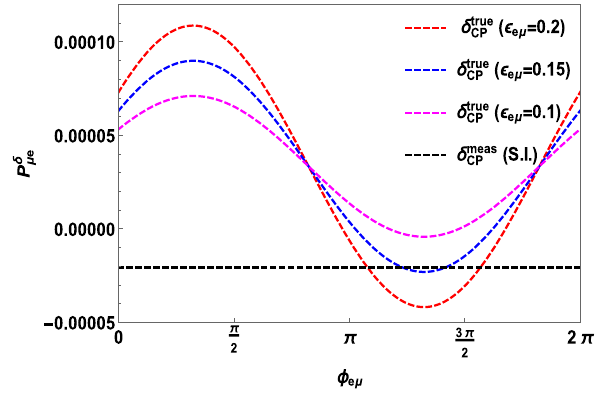
Fig. 3 Appearance probability P δ μ e versus φ e μ assuming standard interactions (black curve) and NSI for different values of ε e μ